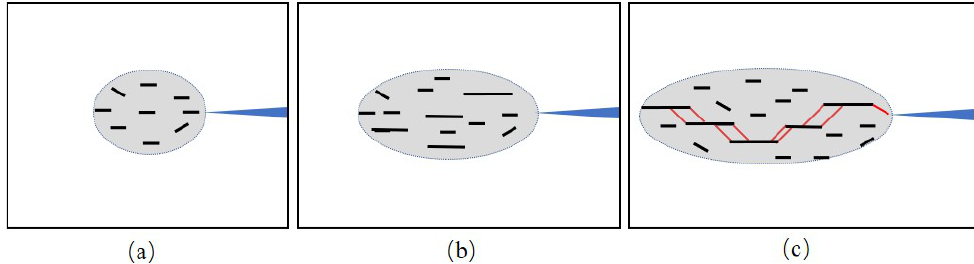
Figure 19. The three stages of the type-I crack structure from static loading to crack propagation: ( a ) there is stress concentration at the crack tip, and micro-cracks and the process zone appear; ( b ) the load continues to increase, the number of micro-cracks increases, and the process zone becomes larger; ( c ) when the load reaches the peak value, the micro-cracks penetrate each other, new macroscopic cracks appear, and the cracks expand.